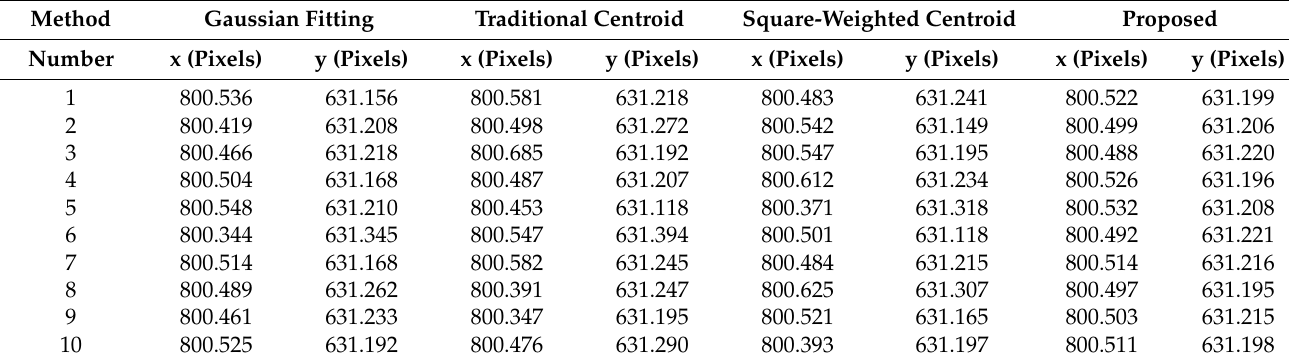
Table 2. Laser spot center located by different